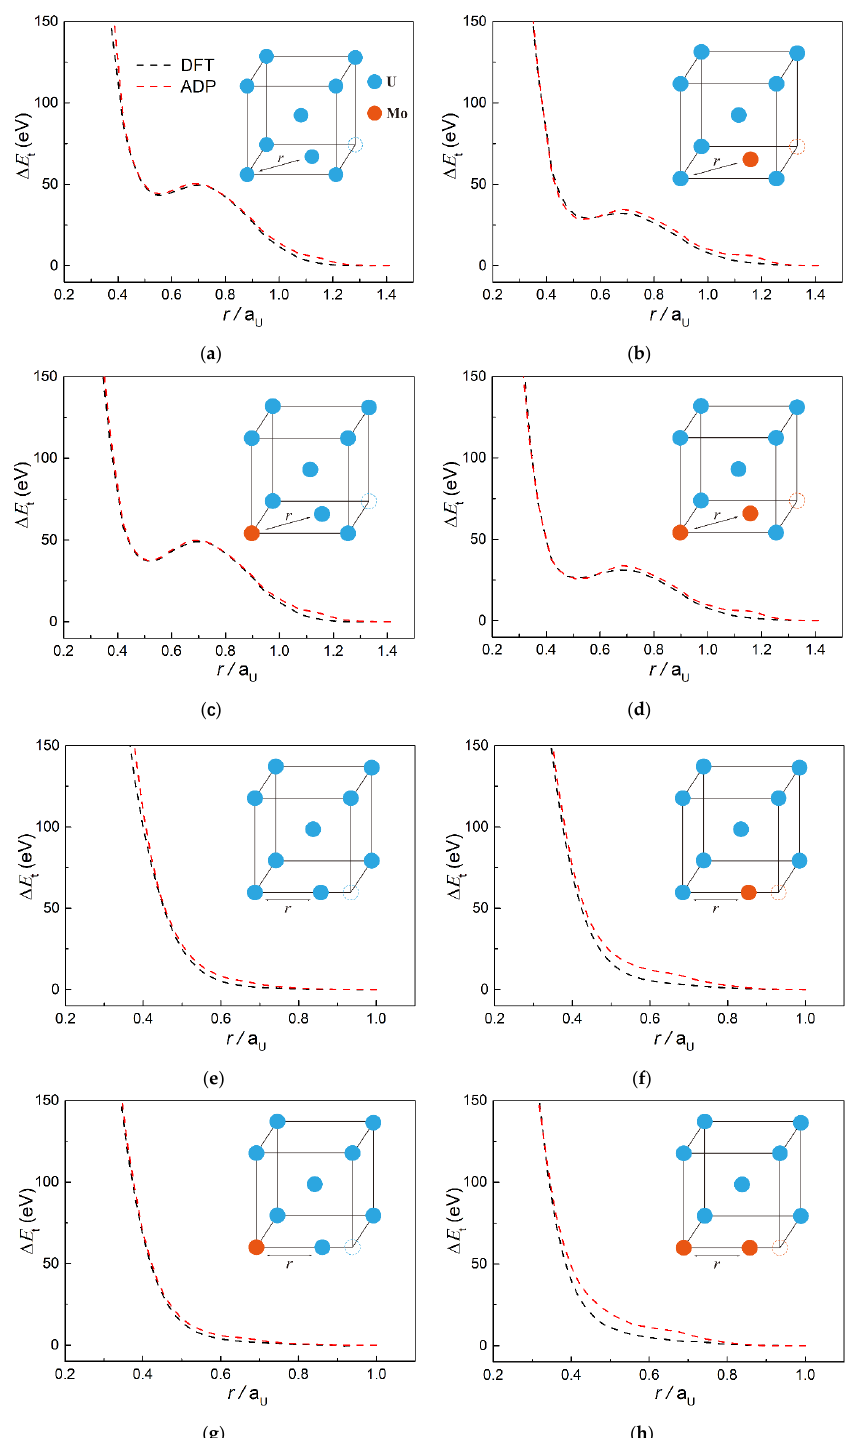
Figure 1. The energetics of the supercell as a function of the ratio between the distance of the nearing dimers and the lattice constant of bcc U. In particular, nearing atom pairs include ( a ) U–U in <110>, ( b ) U–Mo in <110>, ( c ) Mo–U in <110>, ( d ) Mo–Mo in <110>, ( e ) U–U in <100>, ( f ) U–Mo in <100>, ( g ) Mo–U in <100> and ( h ) Mo–Mo in <100>. The black and red dash lines represent calculation results from DFT and MD using ADP. In the configuration diagrams, blue and orange circles represent U and Mo atoms, respectively, and the original positions of displaced atoms are indicated by dotted circles.